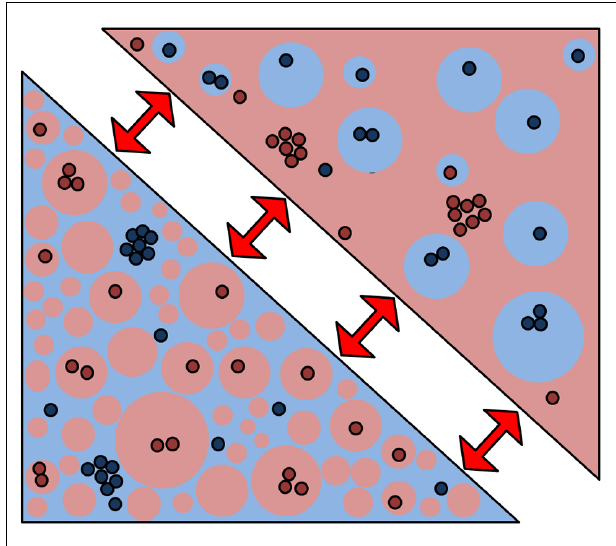
FIGURE 4 |A new membrane model based on percolating phase switching. A new membrane model emerged from our data that indicates that the plasma membrane is indeed a mixture of ordered (red) and disordered (blue) phases where the ordered phase is the majority.Without changing the fraction, protein interactions may be regulated when the geometry of the phases switches (red arrows) from the percolating to the “island” phase. In so-called critical fluctuations, even small perturbations can trigger large-scale changes such as phase